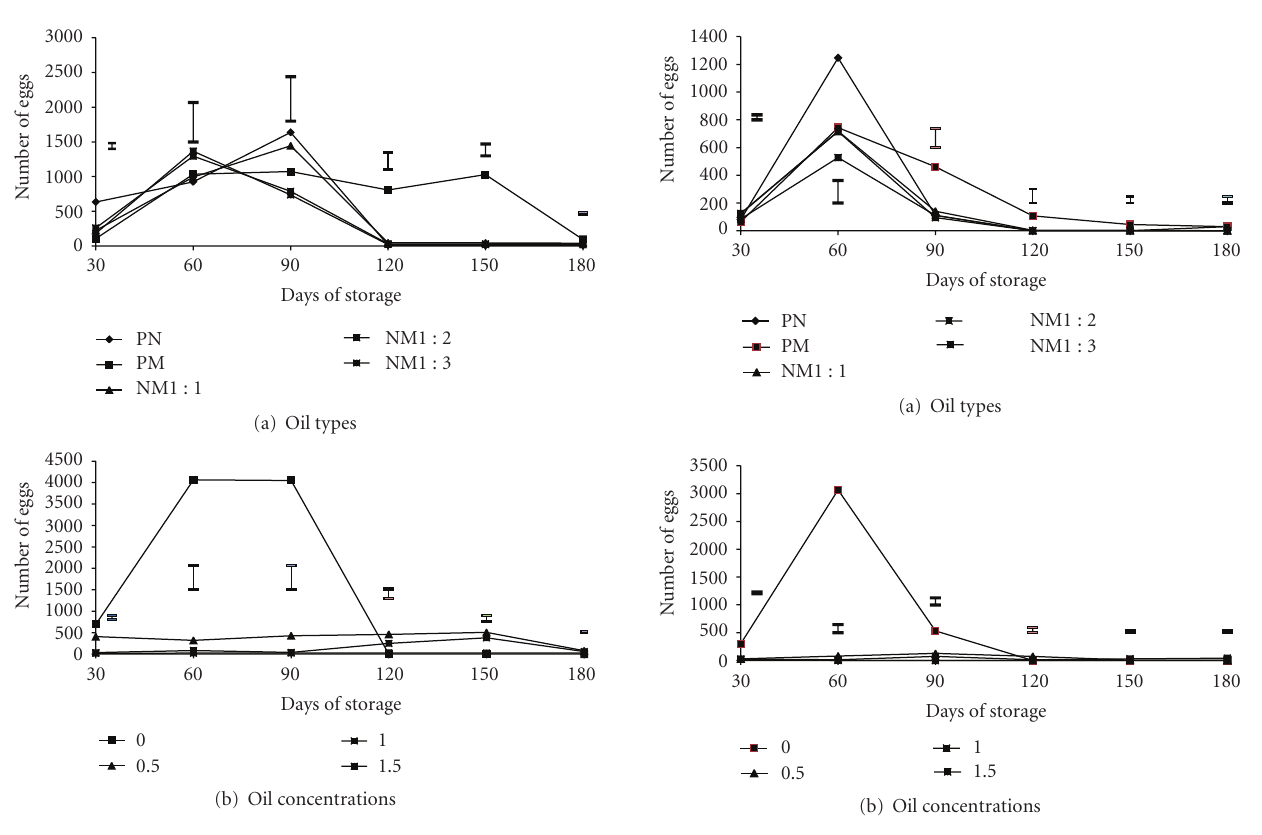
Figure 2: E ff ect of oil types and concentrations on total weevil population in cowpea storage. Vertical lines are LSD bars at P = .